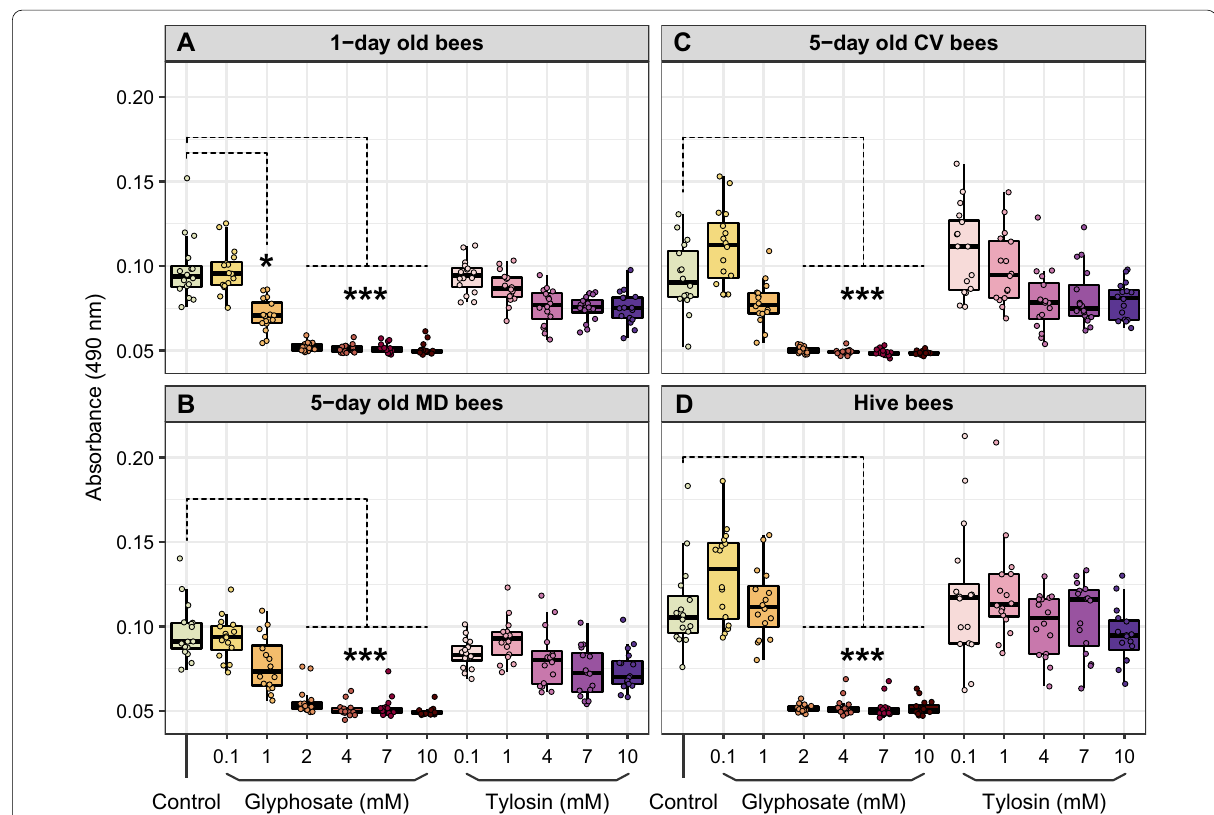
Fig. 6 Ex vivo experiments to investigate the effects of glyphosate or tylosin exposure on the melanization cascade in the hemolymph of honey bees. A – D The formation of dopachrome, an intermediate quinone of the melanization cascade, was measured after adding different concentrations of glyphosate or tylosin to the hemolymph extracted from A 1-day old bees, 5-day old bees B lacking or C containing a normal microbiota, and D hive bees. n 16 samples per group. Samples were incubated for 30 min at 30 °C, and absorbance was measured at 490 nm. = Significance between groups in each assay was measured with Kruskal–Wallis tests followed by Dunn’s multiple-comparison tests. * p < 0.05 and *** p < 0.001. MD microbiota defective, CV conventional